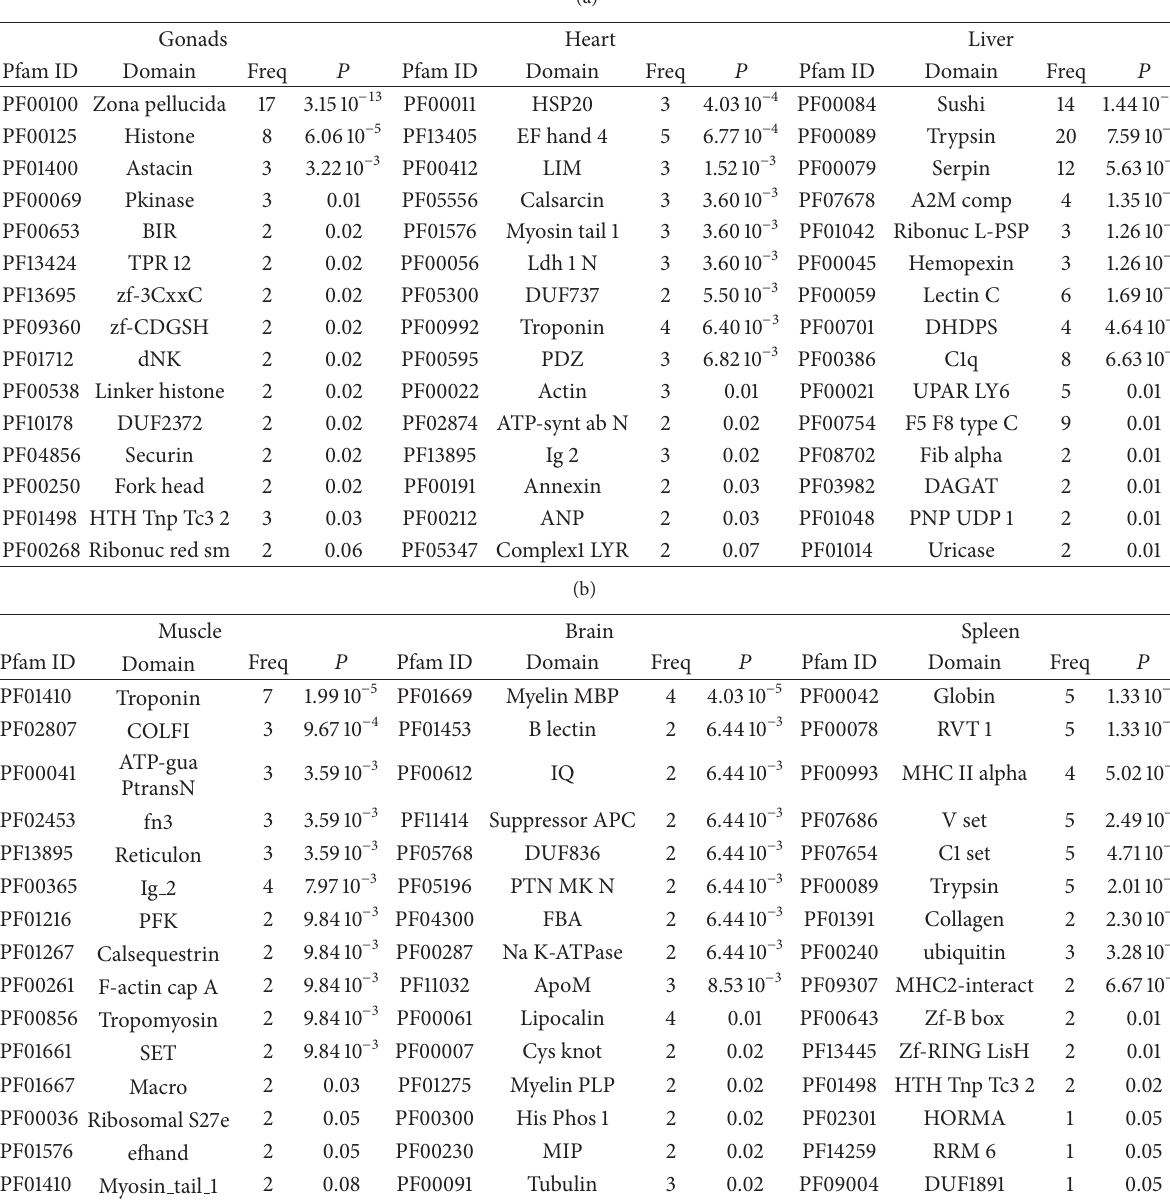
Table 4: List of Pfam conserved domains that were tissue specifically expressed in Aphanopus carbo transcriptome. Frequencies and 𝑃 -values of tissue specificity analysis are